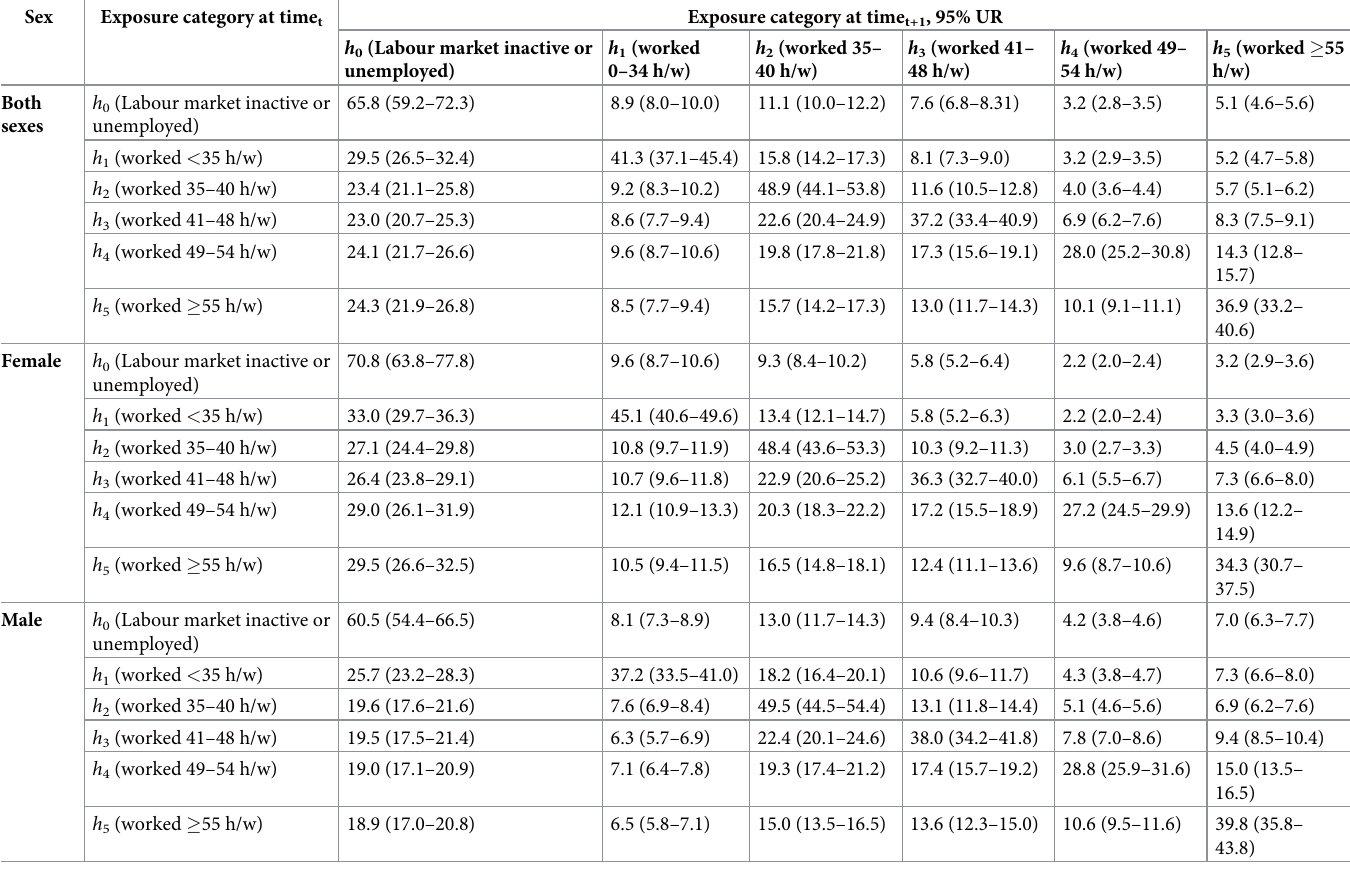
Table 1. Output from Model 2: Transition probability in percentage (and 95% uncertainty intervals) between exposure categories for males and females combined (both sexes) and